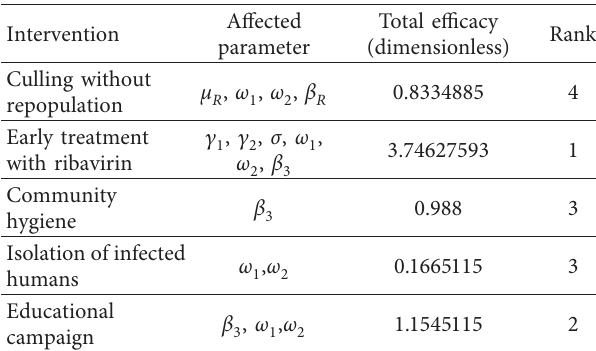
Table 4: The list of intervention strategies and their efficacy. Intervention